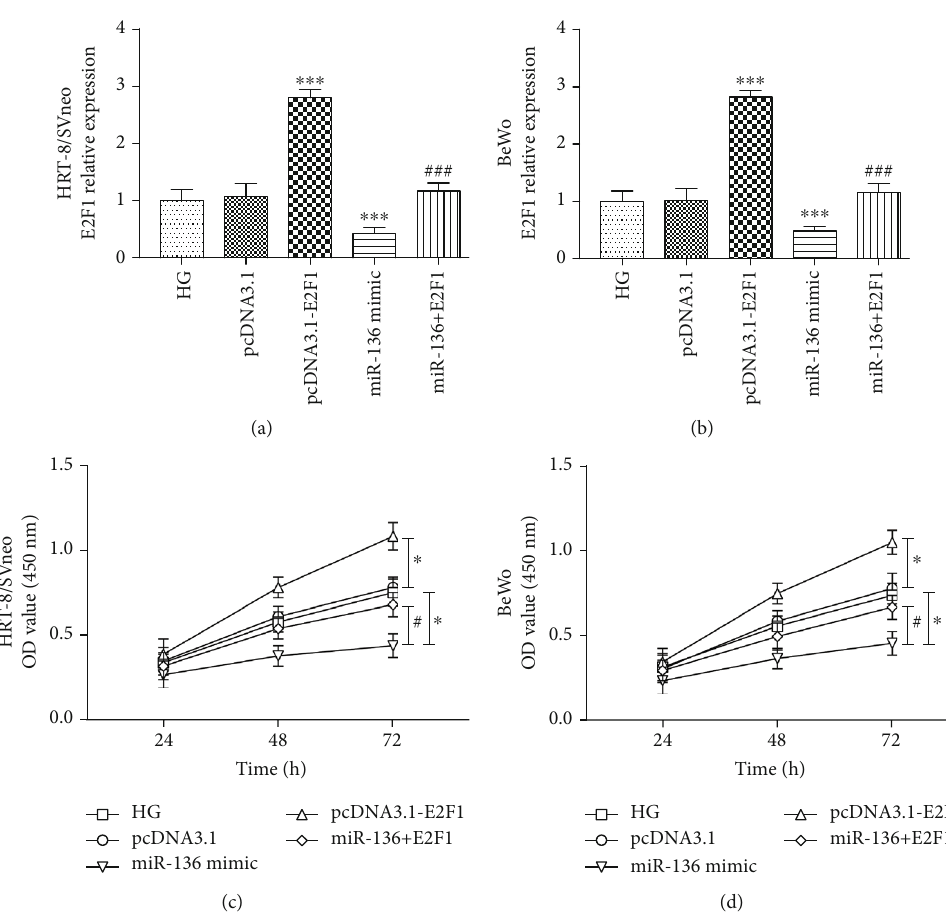
Figure 5: E ff ect of E2F1 on trophoblast cell proliferation. (a, b) The expression of E2F1 was upregulated by pcDNA.1-E2F1, and the inhibited E2F1 by miR-136 overexpression was abolished by pcDNA3.1-E2F1 in both HRT-8/SVneo and BeWo cells ( ∗∗∗ P < 0 : 001 vs. HG; ### P < 0 : 001 vs. miR-136 mimic). (c, d) The inhibited trophoblast cell proliferation induced by the miR-136 overexpression was reversed by the upregulation of E2F1 in both HRT-8/SVneo and BeWo cells ( ∗∗∗ P < 0 : 001 vs. HG; ### P < 0 : 001 vs. miR-136 mimic). HG: high